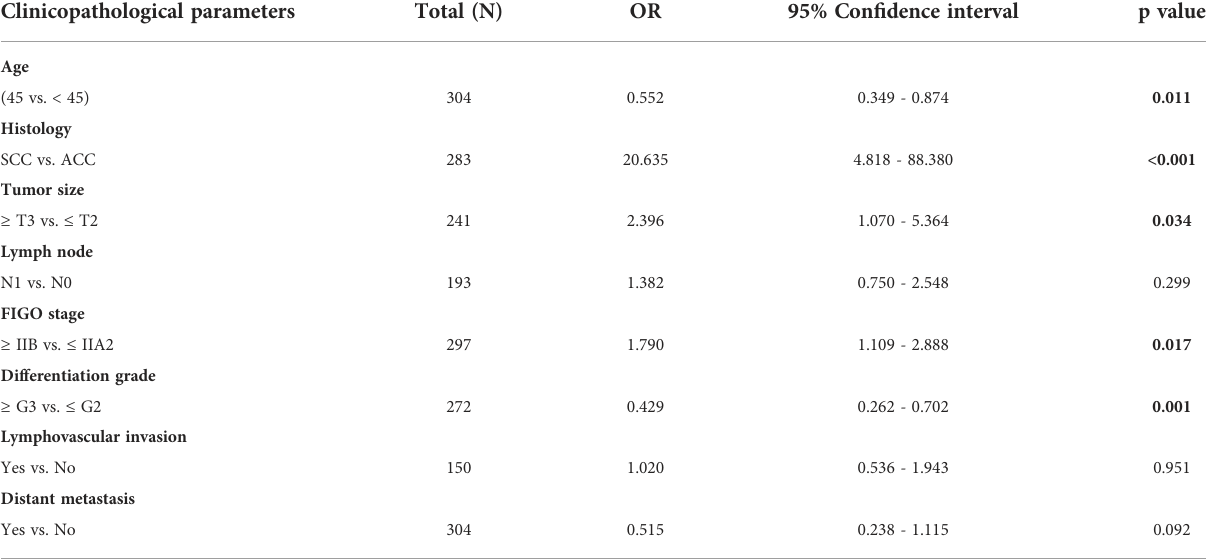
TABLE 3 GJB2 expression correlated with clinical factors (logistic regression). Clinicopathological